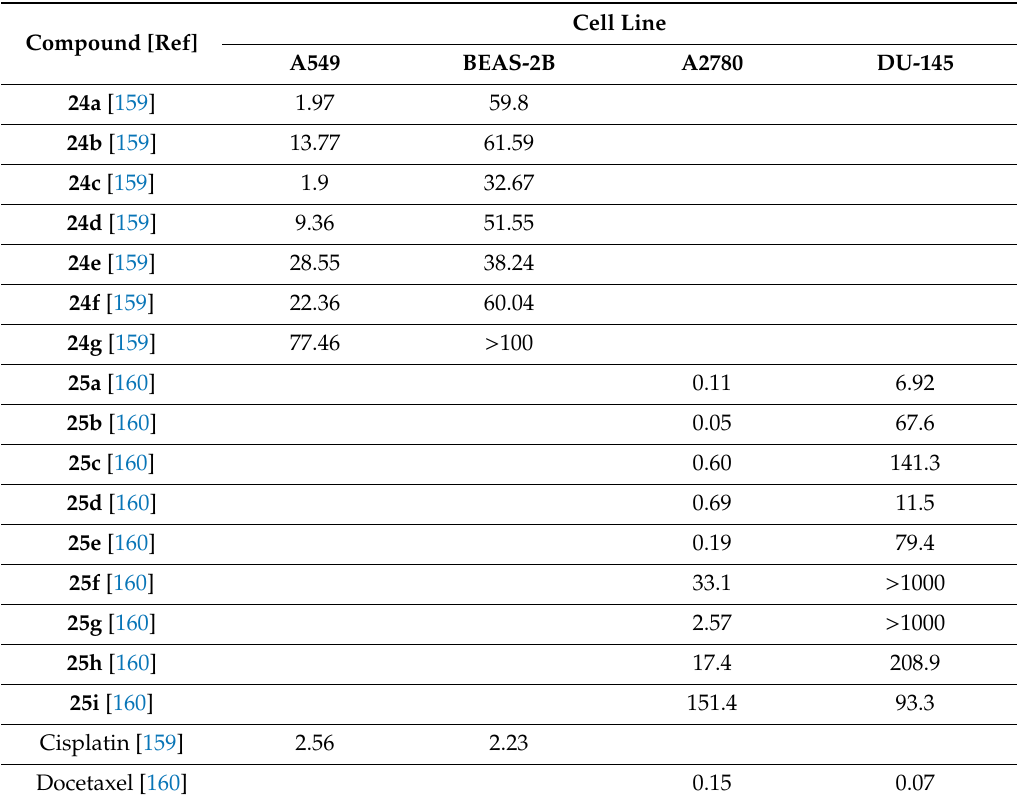
Table 7. IC 50 values ( µ M) for zinc complexes 24 and 25 , and references cisplatin and docetaxel against di ff erent tumor and normal (BEAS.2B) cell lines after an incubation time of 72 h.